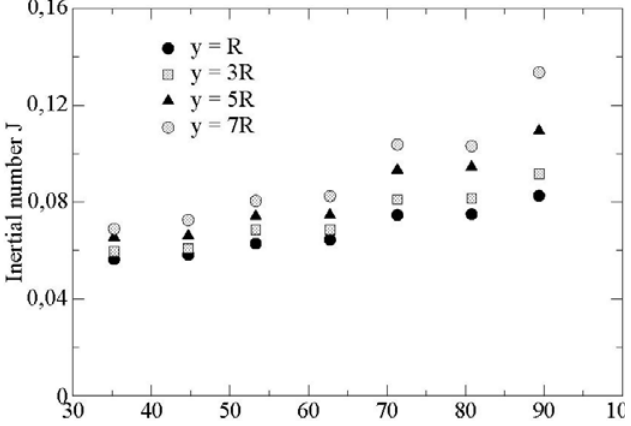
Figure 4. Inertial number J as a function of angular displacement ( x = 33 R, t = 0.015